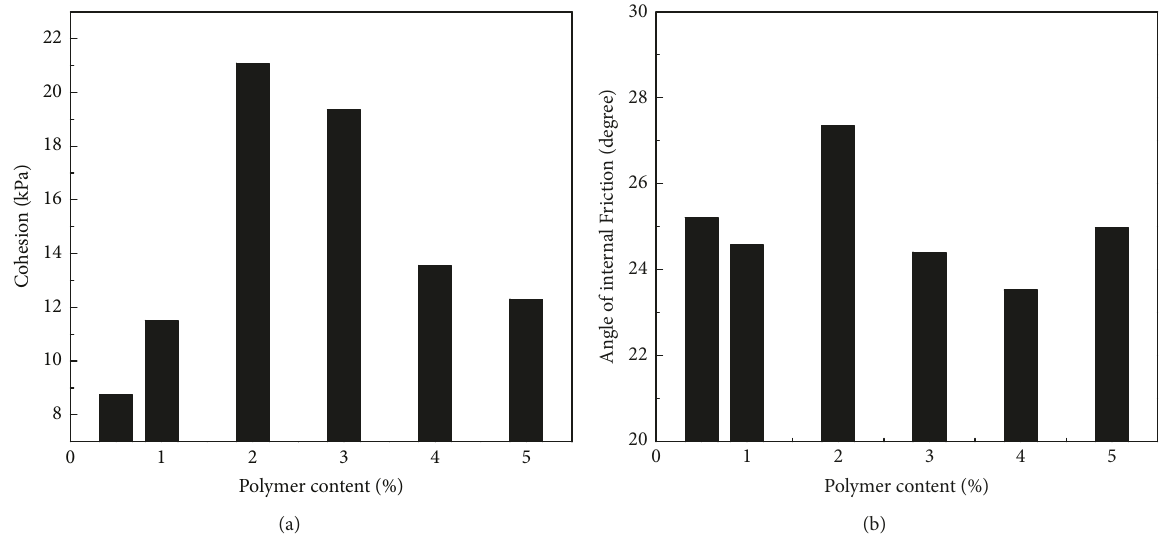
Figure 6: The direct shear strengths of specimens: (a) cohesion; (b) internal friction angle.